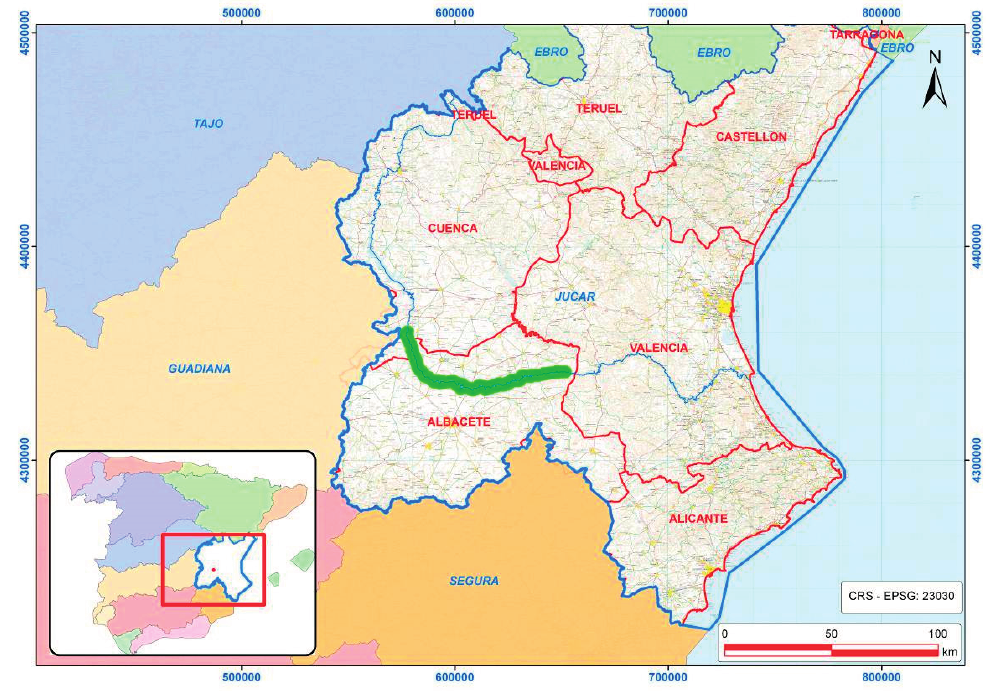
Figure 2. Location of the case study (green